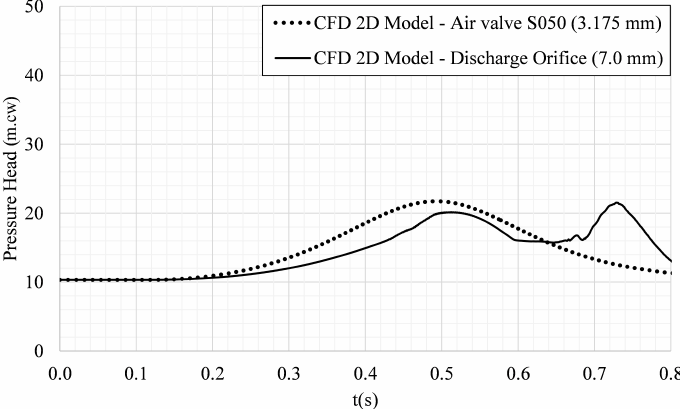
Figure 7. Comparison of air pocket pressure patterns using the S050 air valve (diameter of 3.175 mm) and the 7.0 mm discharge